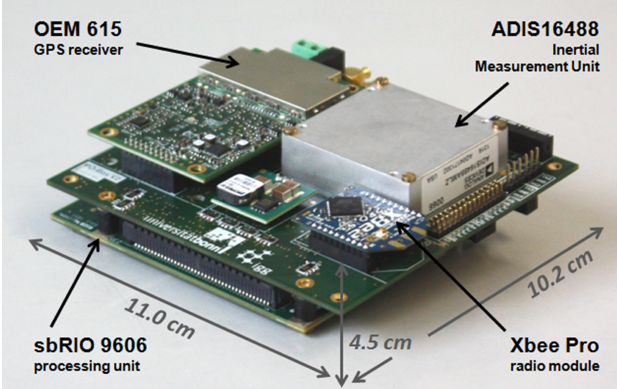
Figure 2. The direct georeferencing system, with its components.